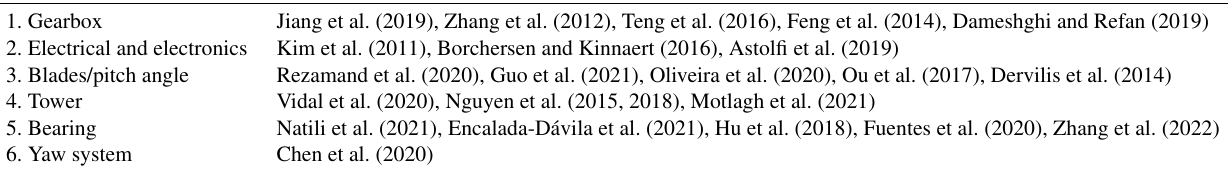
Table 1. Papers based on the detection of faults classified according to the main component or system of the WT. 1. Gearbox